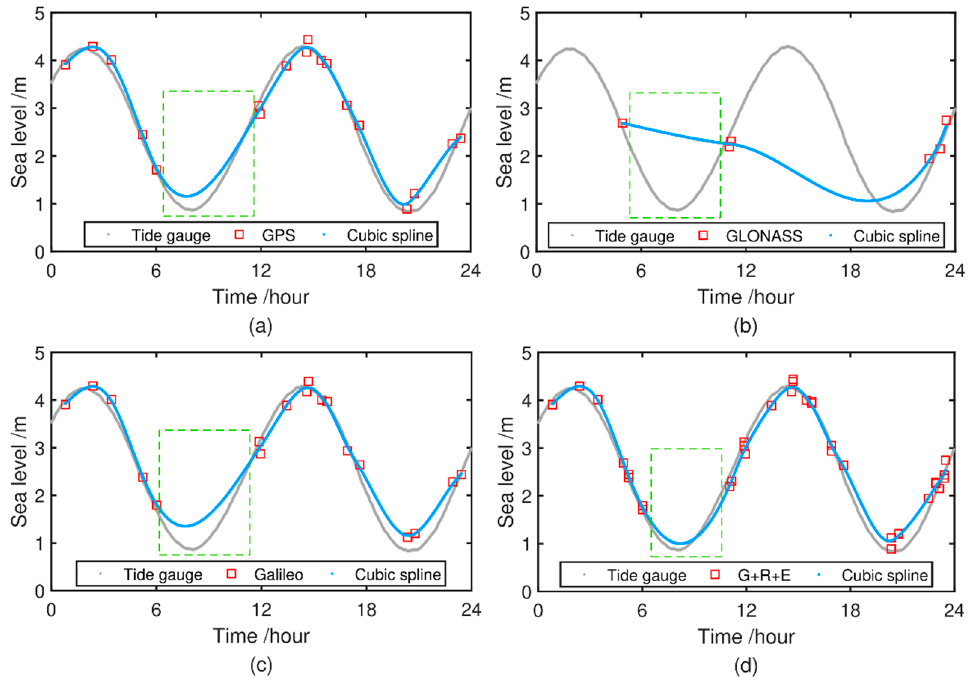
Figure 13. Smoothed SSH time series of site SCOA estimated by PE measurements for different constellations on DOY 1, 2022. ( a ) GPS; ( b ) GLONASS; ( c ) Galileo; ( d ) multi-GNSS